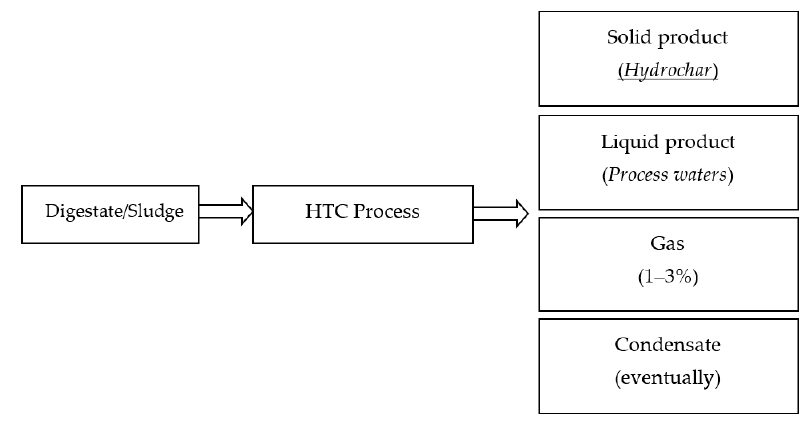
Figure 3. HTC Figure 3. HTC by-products.